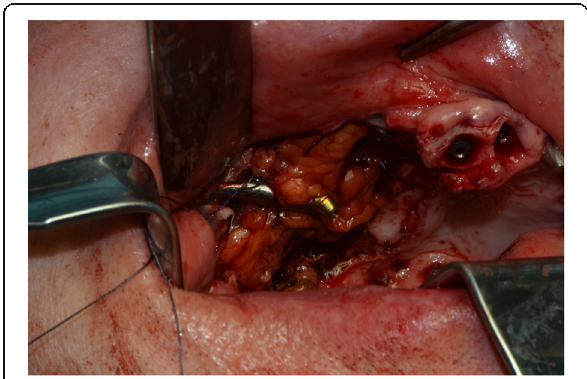
Fig. 14 Pt no. 3. The zygomatic implant emerging in area of tooth 16 and surrounded by the buccal fat pad